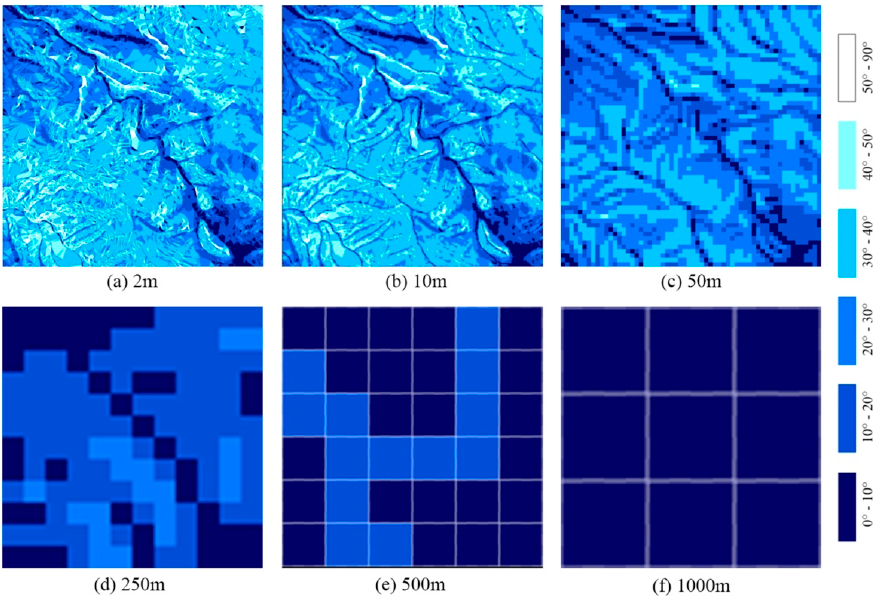
Figure 14. Slope of Dayekou at different scales: ( a ) 2 m; ( b ) 10 m; ( c ) 50 m; ( d ) 250 m; ( e ) 500 m; ( f ) 1000 m.